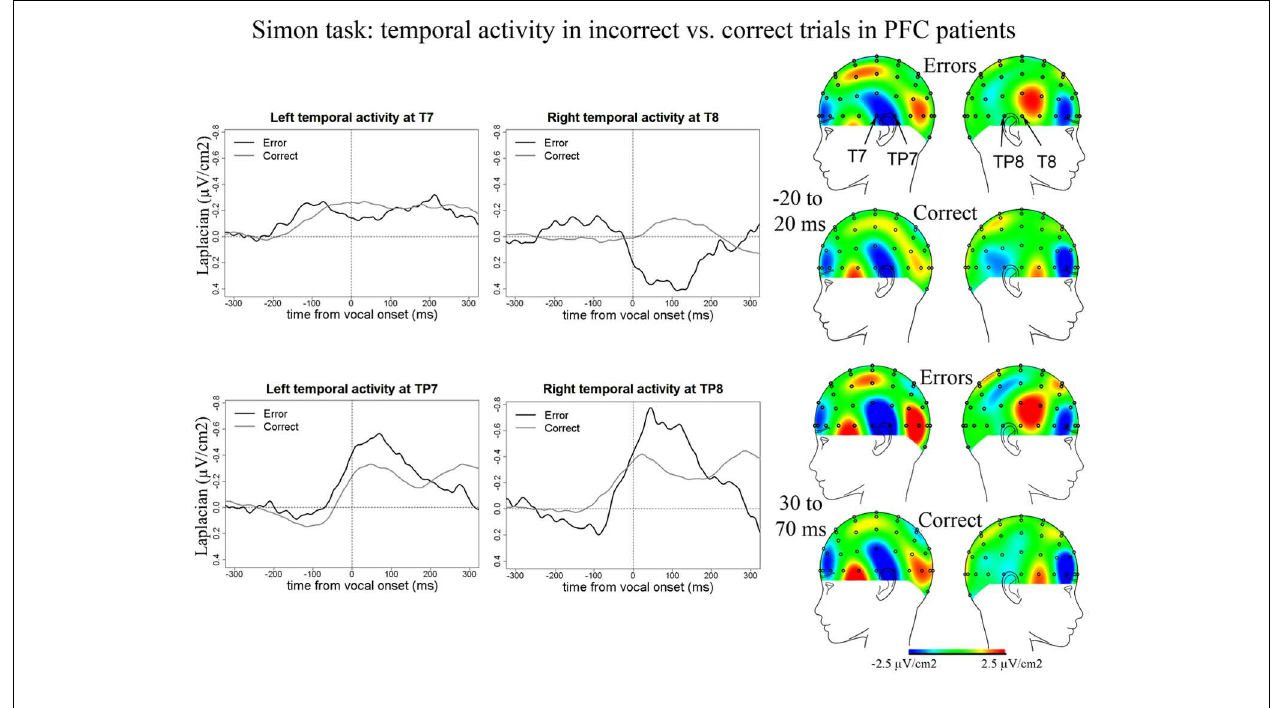
FIGURE 7 | EEG activity in PFC patients after surface Laplacian transformation in the Simon task, recorded at left (T7, TP7) and right (T8, TP8) temporal electrodes for error (black line) and correct trials (gray line). Zero time represents vocal onset. The cartographies